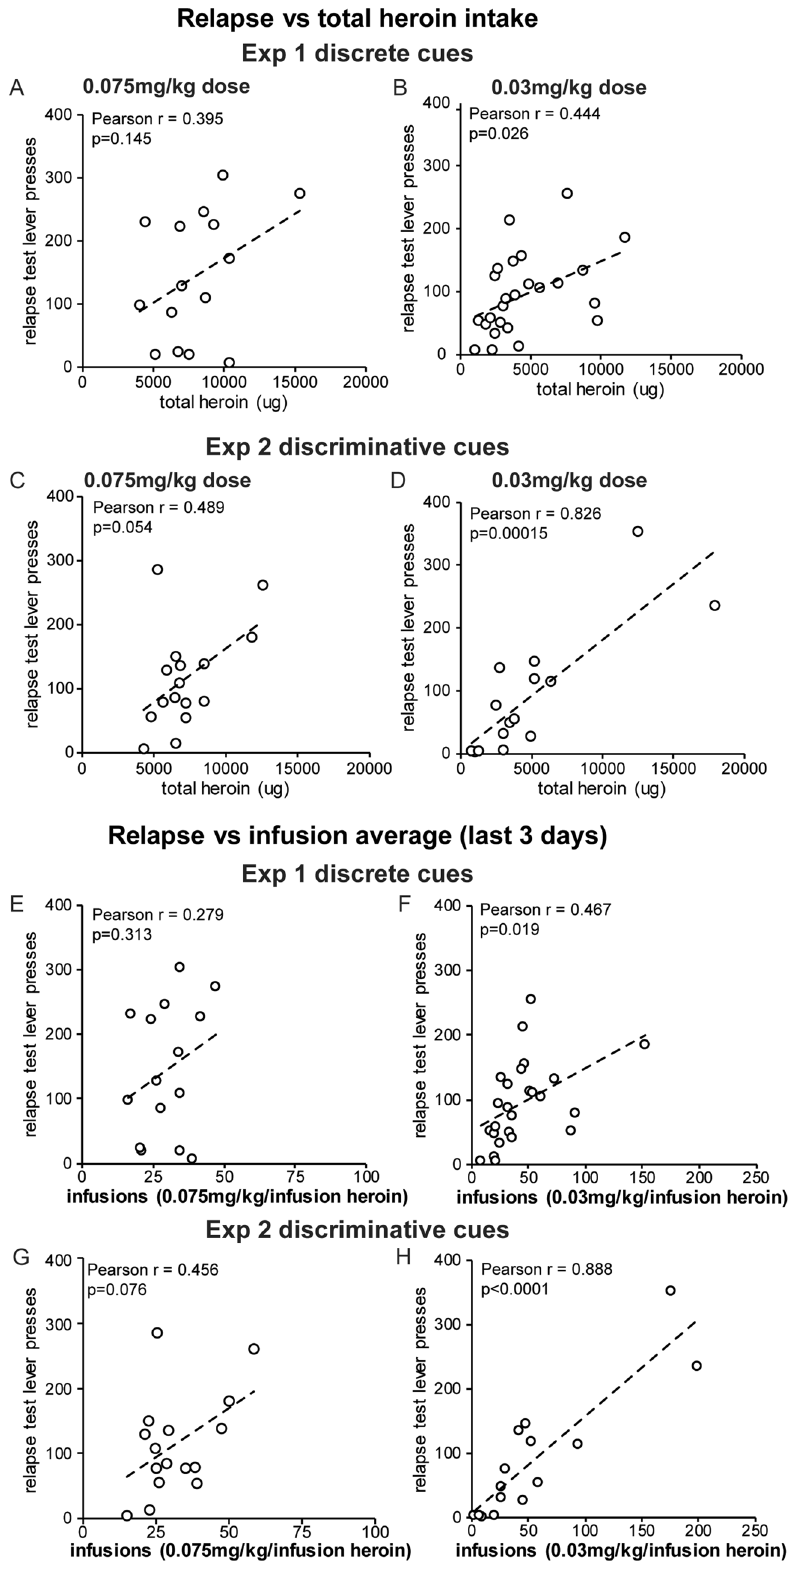
Figure 4. Total drug intake contributes to relapse behavior for low-dose heroin self-administration protocols with either discrete or discriminative drug cues. Lever pressing during the 90 min relapse test for both 2 and 21 days abstinence animals was correlated to each animal’s total drug intake during self-administration ( A – D ) or the average of infusions on the last three days of self-administration ( E – H ) for experiment 1 ( A , B , E , F ) and 2 ( C , D , G , H ). Pearson r values and p -values are shown for each comparison. * p <